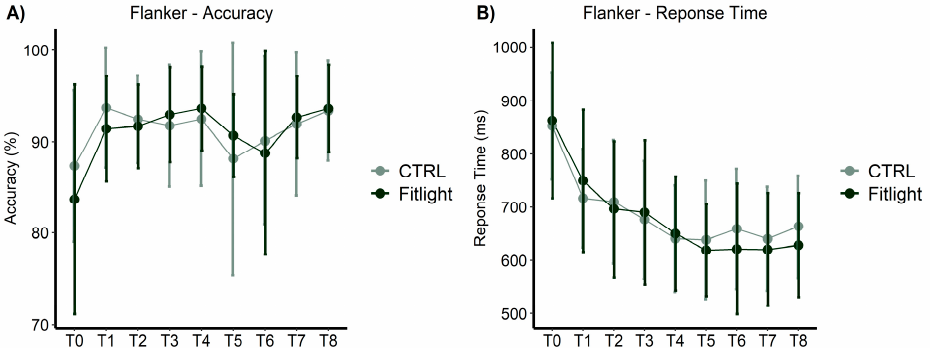
Figure 2. Flanker/Reverse Flanker task measures over time and between the groups in all conditions: ( a ) Accuracy in the Flanker/Reverse Flanker task; ( b ) response time in the Flanker/Reverse Flanker task.